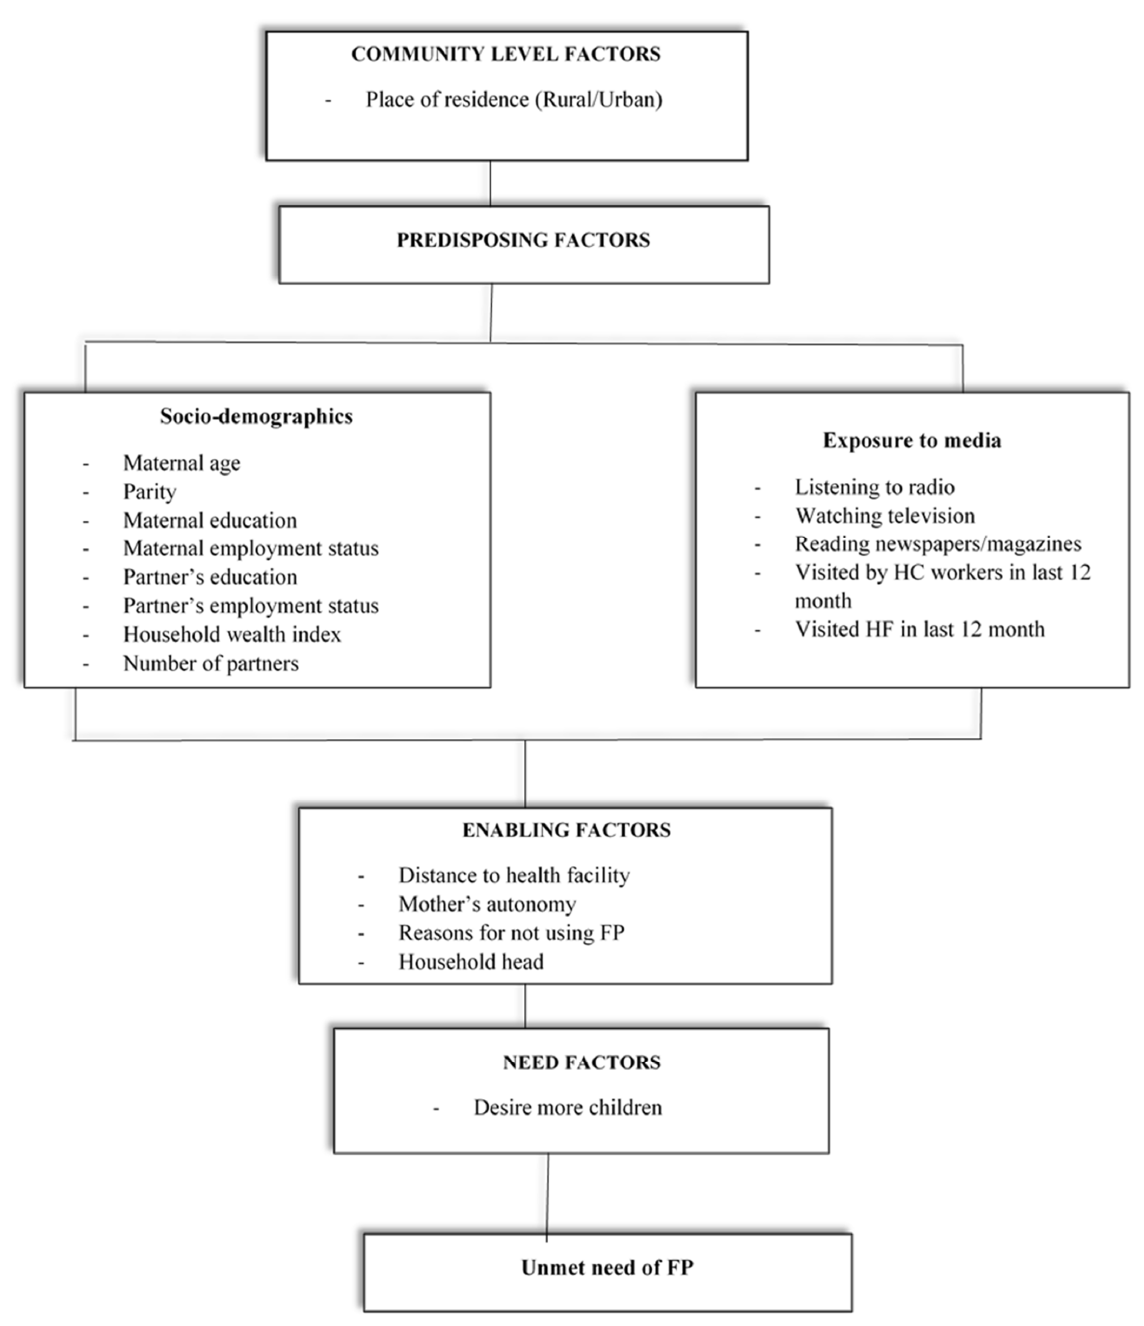
Figure 1. Conceptual model for unmet need for FP adopted from Anderson’s health service utiliza- tion model